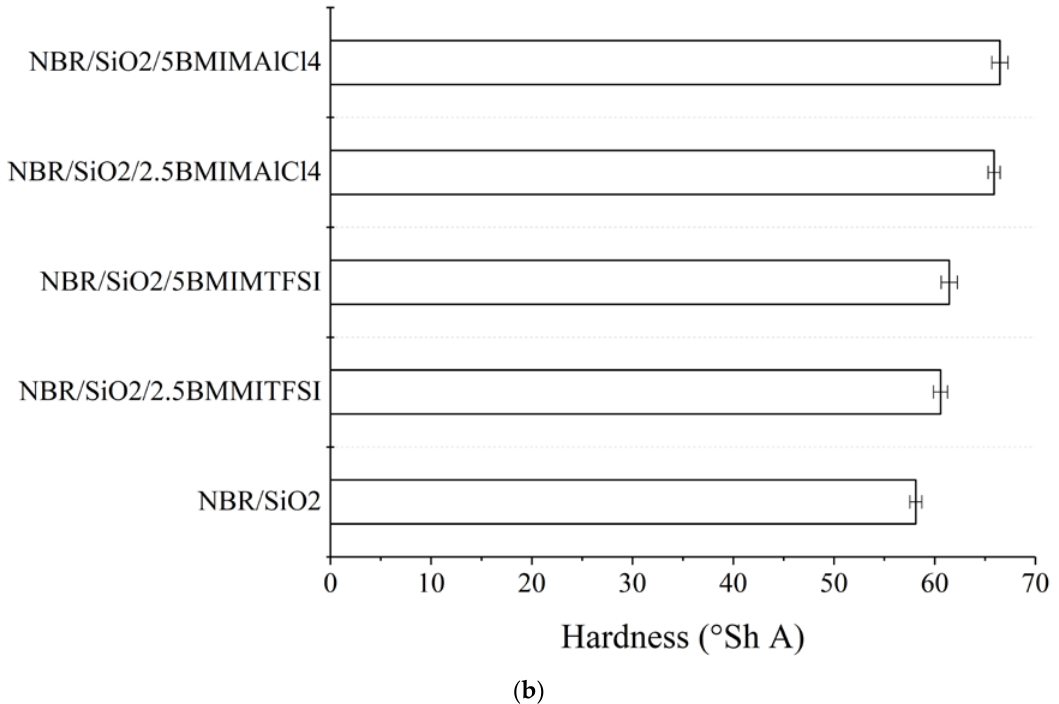
Figure 3. Mechanical properties ( a ) and hardness ( b ) of NBR composites containing BMIMTSFI and BMIMAlCl 4 .